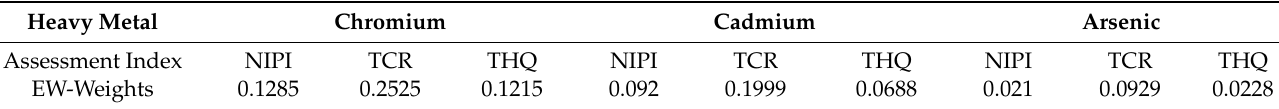
Table 3. Entropy weights of NIPI, TCR, and THQ for chromium, cadmium, and arsenic.